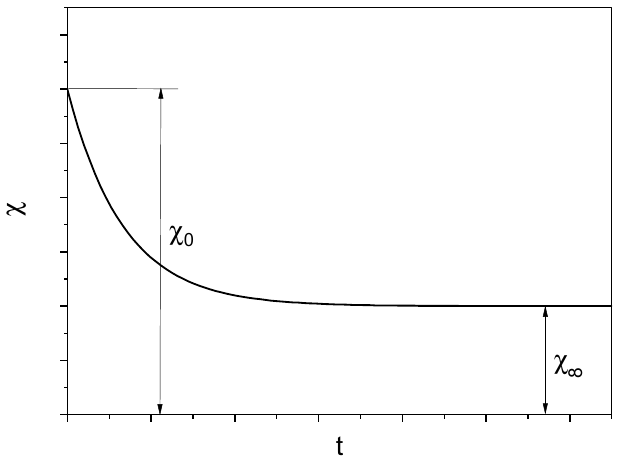
Figure 8. Disaccomodation curve of magnetic susceptibility χ from time t , χ 0 —magnetic susceptibility at time t = 0, χ ∞ —magnetic susceptibility for t → ∞ [24].